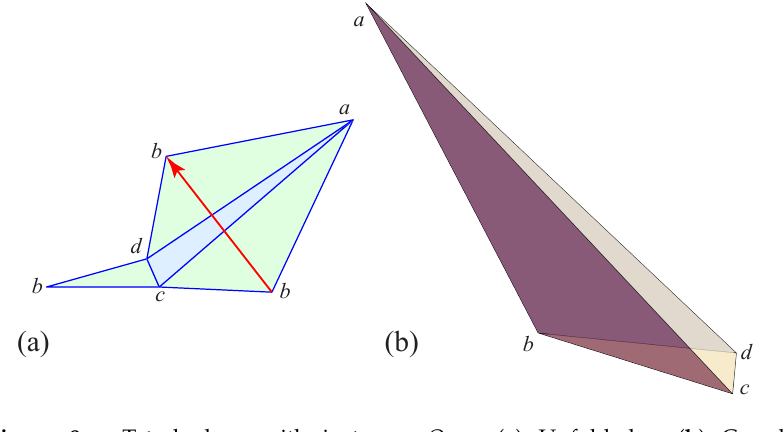
Figure 8. Tetrahedron with just one Q 1 . ( a ) Unfolded. ( b ) Coordinates of a , b , c , d : ( − 0.65,0,1.56 ) , ( 0,0,0 ) , ( 1,0,0 ) , ( 0.89,0.25,0 )